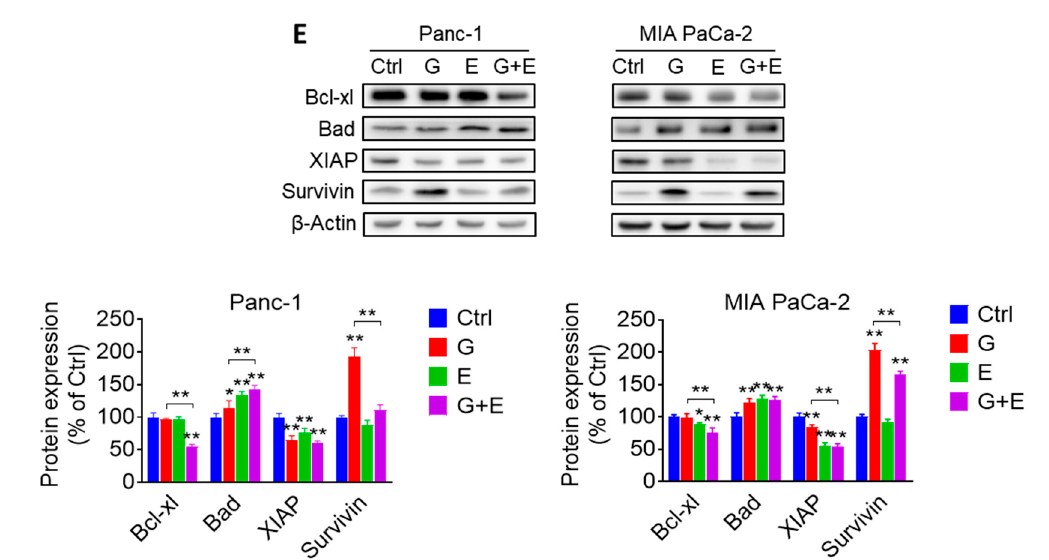
Figure 6. EGCG and gemcitabine together further a ff ected cell kinetic in pancreatic cancer cells. ( A ) EGCG (E) enhanced the e ff ect of gemcitabine (G) on the cell cycle. Following treatment with 40 µ M EGCG (E), 20 nM gemcitabine (G), or both (G + E) for 48 h, cells were stained with propidium iodide (PI) and the number of cells in each phase of the cell cycle was measured by flow cytometry. Results are expressed as a percentage of control. ( B ) EGCG (E) and gemcitabine (G) modulated S / G2 phase protein expression. Immunoblots for phosphorylated checkpoint kinases 1 (p-Chk1), phosphorylated and total tumor protein p53 (p53), cyclin-dependent kinase (cdk) inhibitor p21 Waf1 / Cip1 (p21), cell division cycle 2 (cdc2) and Cyclin B1 in total cell protein extracts from Panc-1 and MIA PaCa-2 cells treated with EGCG (E), gemcitabine (G), or both (G + E), for 48 h. Loading control: β -Actin. Bands were quantified and results are expressed as a percentage of control. * p < 0.05, ** p < 0.01 vs. control. ( C ) Panc-1 and MIA PaCa-2 cells were treated with EGCG (E), gemcitabine (G), or both (G + E) for 48 h, and the percentage of apoptotic cells were determined by flow cytometry using dual staining (Annexin V and propipium iodide). The percentages of Annexin V ( + ) cells was calculated, and results are expressed as the fold-increase over control. Co-treatment with EGCG (E) further increased the apoptosis rate induced by gemcitabine (G) alone after 48 h. Results are expressed as percentage of control. * p < 0.05, ** p < 0.01 vs. control. ( D ) Immunoblots for full length and cleaved Caspases 3, 7 and 9 as well as full length and cleaved poly (ADP-ribose) polymerase (PARP) in total cell protein extracts from Panc-1 and MIA PaCa-2 cells treated with EGCG (E), gemcitabine (G), or both (G + E) for 48 h. Loading control: β -Actin. Bands were quantified and results are shown as the ratio between the cleaved / full length protein; * p < 0.05, ** p < 0.01 vs. control. ( E ) EGCG sensitized gemcitabine on apoptosis induction by regulating B-cell lymphoma 2 (Bcl-2) family and Inhibitors of apoptosis proteins (IAP) family protein expression in Panc-1 and MIA PaCa-2 cells after 48 h. Results are expressed as percentage of control. * p < 0.05, ** p < 0.01 vs. control.